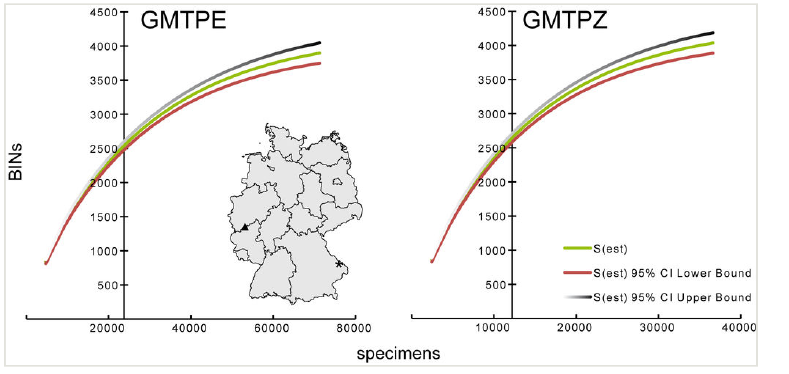
Figure 1. Accumulation curves showing the number of BINs versus the number of specimens analyzed from the two sample locations based on collections from May to September. The map illustrates the location of the two Malaise traps within Germany. Note that the y-axis cuts at the actual number of specimens analysed. Asterik = GMTPE: Nationalpark Bayerischer Wald Triangle = GMTPZ: Middle River Rhine